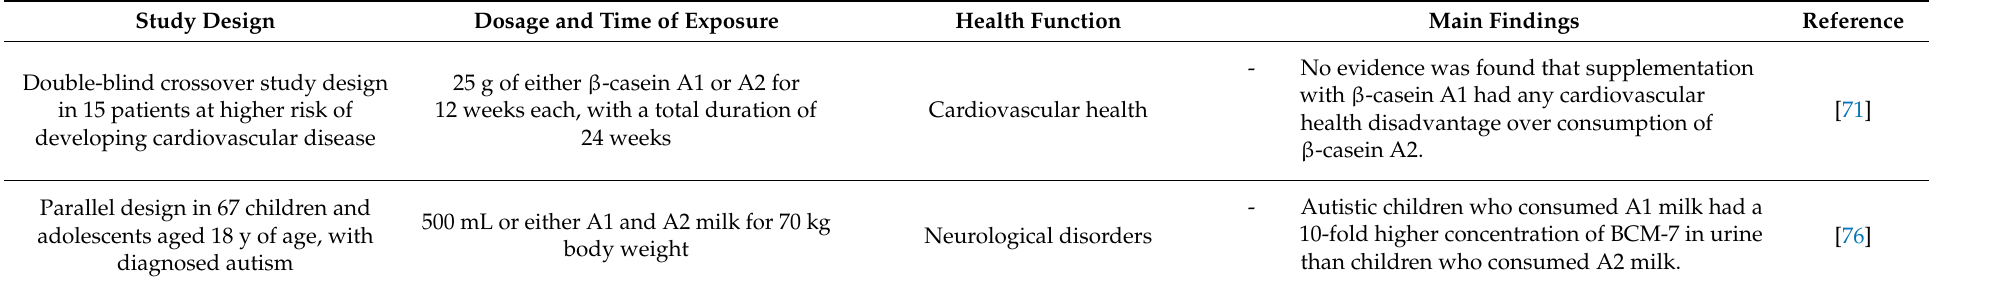
Table 3. Use of A2 milk in human clinical trials to treat or prevent different health